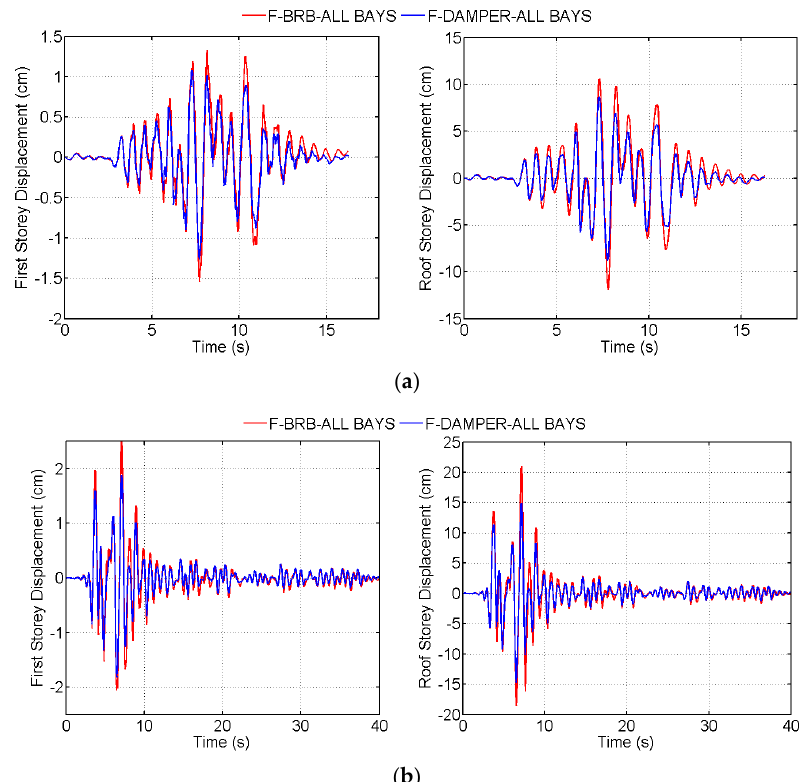
Figure 16. Displacement time history under ( a ) Gazlı and ( b ) Northridge earthquakes, showing the minimum and maximum values for the 8-story frames with BRBs and VDs.